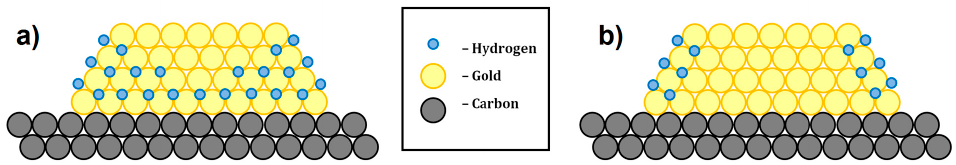
5 of 12 Figure 2. HOPG-supported gold nanoparticle after 200 L exposure to hydrogen: ( a ) topography image of the HOPG surface area with nanoparticle, ( b ) averaged VAC curves corresponding to the points indicated on the topography image.